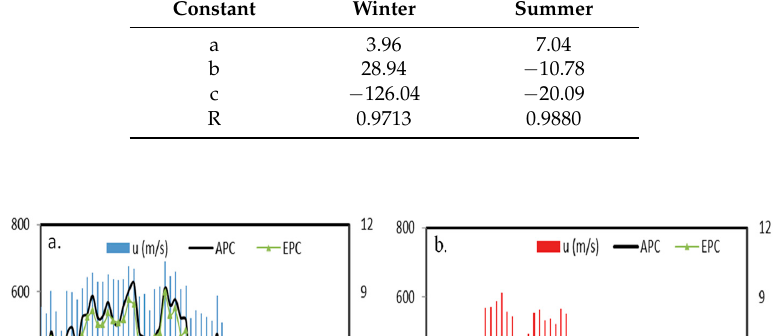
Table 3. Details of constants and correlation coefficients for the effective power curve.